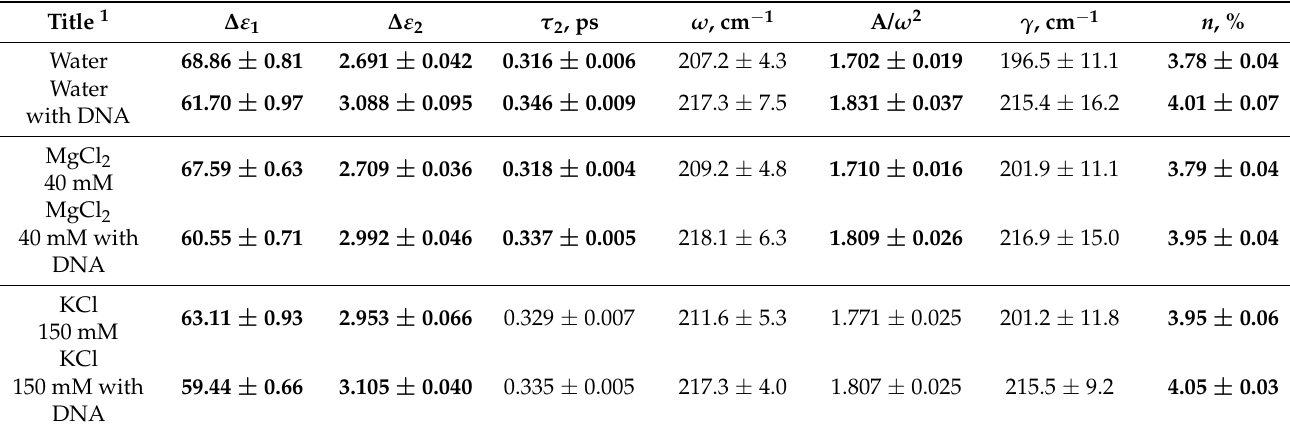
Table 1. The parameters of model DP (5) and the percentage of free water molecules n (7) calculated for all the studied solutions.